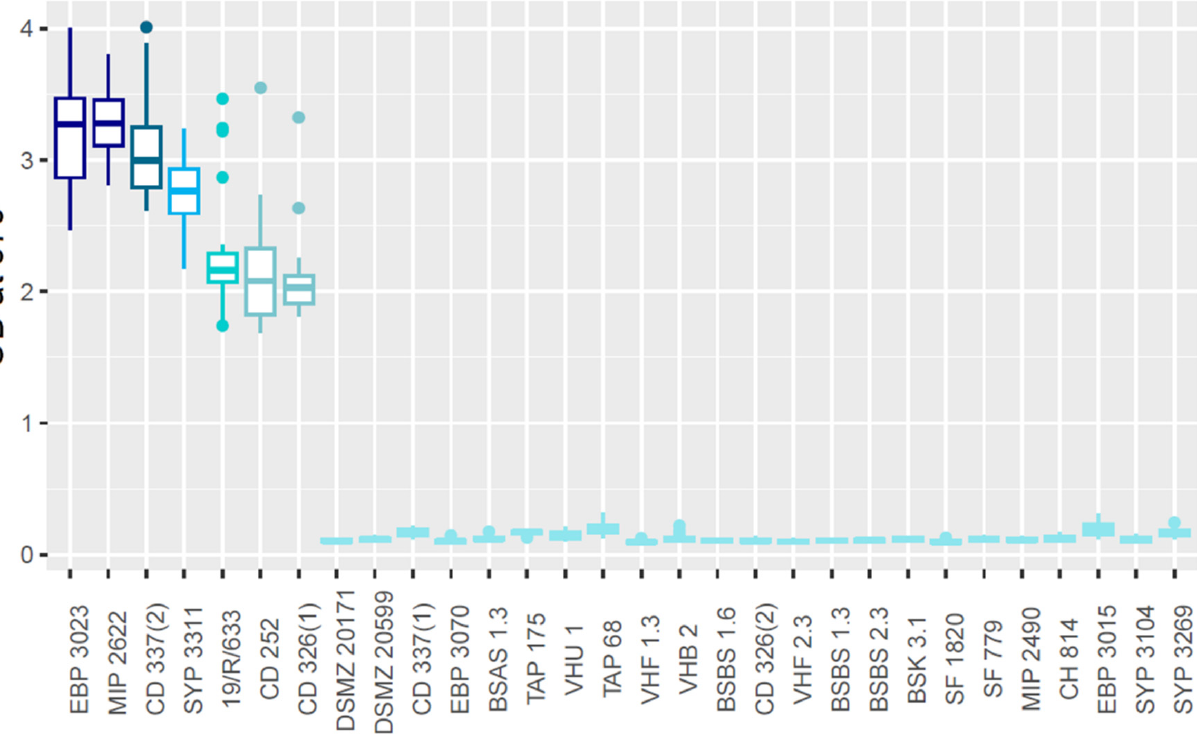
Figure 2. Optical density at 570 nm of biofilm producers stained with crystal violet. Each color group is statistically different from the others ( p < 0.05). A total of 23 strains show a low mature biofilm production, while 5 show a high mature biofilm